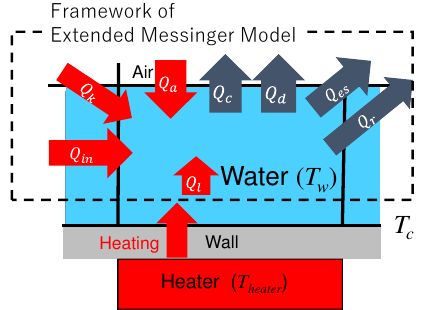
Figure 2. Framework of thermodynamics model used in this study. The arrows represent the energy balance in the wall cell. The red and blue arrows indicate the energy into and out of the cell,